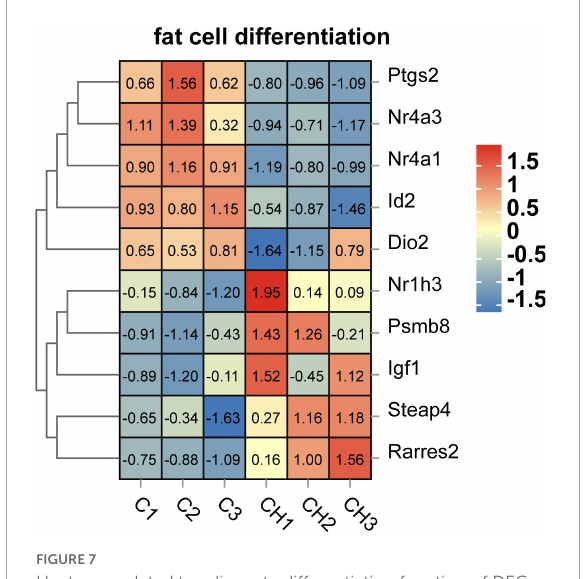
FIGURE7 Heat map related to adipocyte differentiation function of DEGs in C-vs.-CH. C represents three untreated control samples; CH represents three chlorantraniliprole-treated treatment group